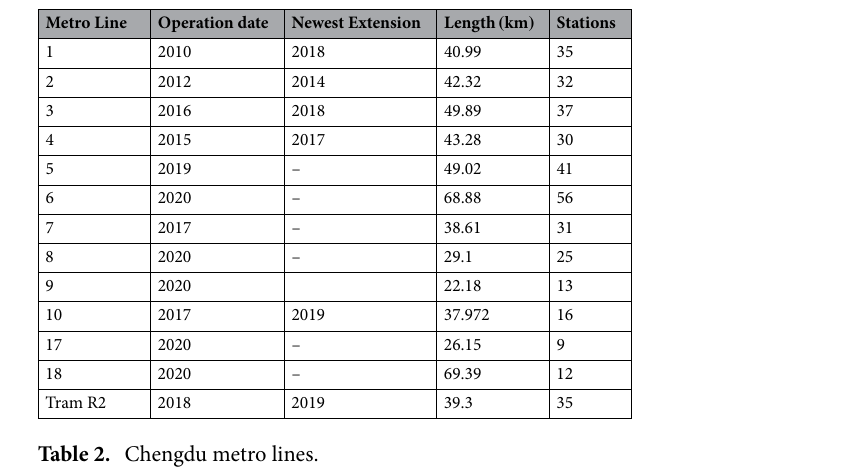
Table 2. Chengdu metro